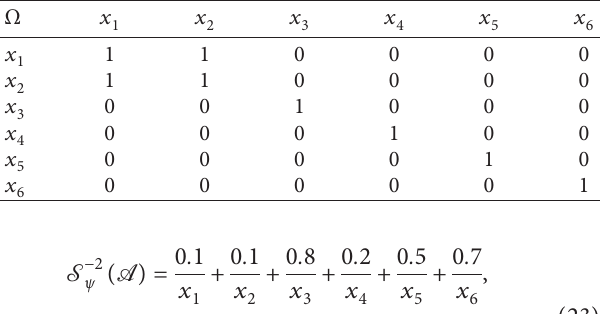
( x ,x ) ∀ i, j ∈ 1 , 2 , ... , 6 { } i j S